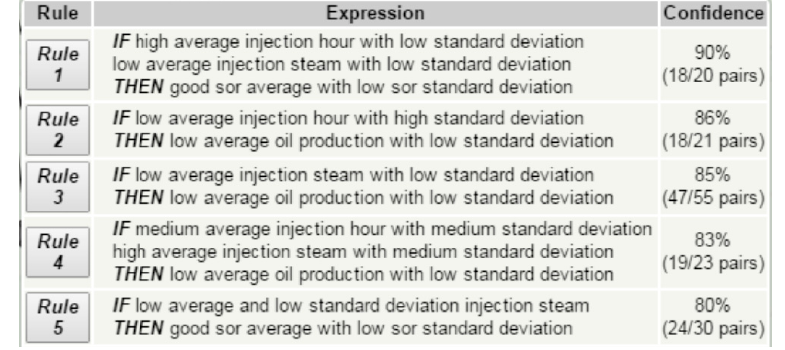
Figure 10. Analysis of operation strategy using ARM.